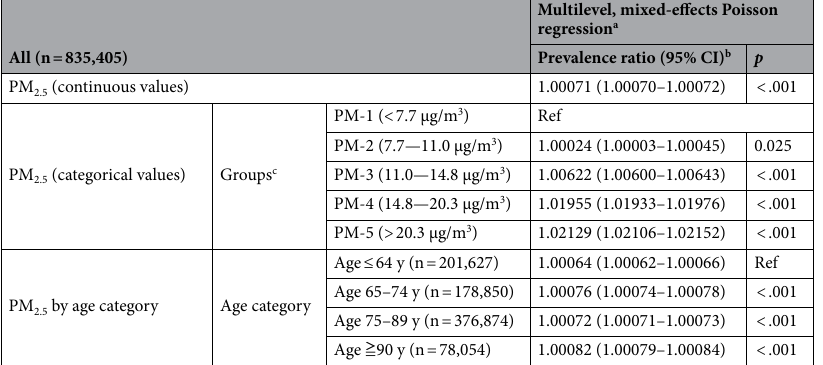
Table 1. Association between PM 2.5 exposure and the CVD prevalence rate. CVD, cardiovascular disease; PM 2.5 , particulate matter with aerodynamic diameters ≤ 2.5 µg/m 3 ; CI, confidence interval. a The mixed models were used to correct for random effects due to interhospital variation. b Prevalence ratios were adjusted for temperature, humidity, eastern/western Japan, season, number of hospital beds, age, sex, height, weight, Brinkman index, and Charlson comorbidity index. c Classified according to PM 2.5 exposure concentration.